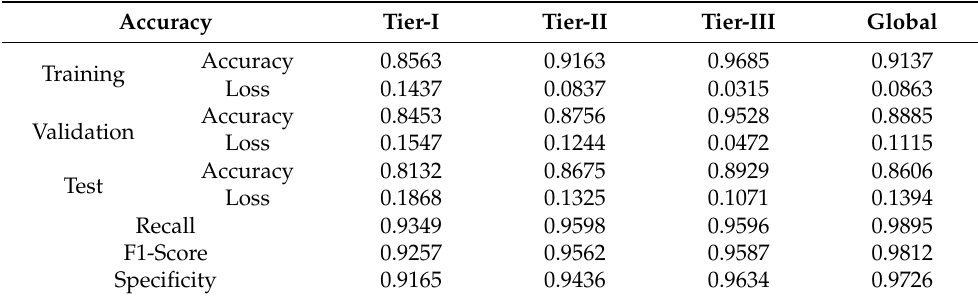
Table 4. Global and individual training, validation, and test accuracies with relevant losses, Recall, F1-Score, and Specificity of